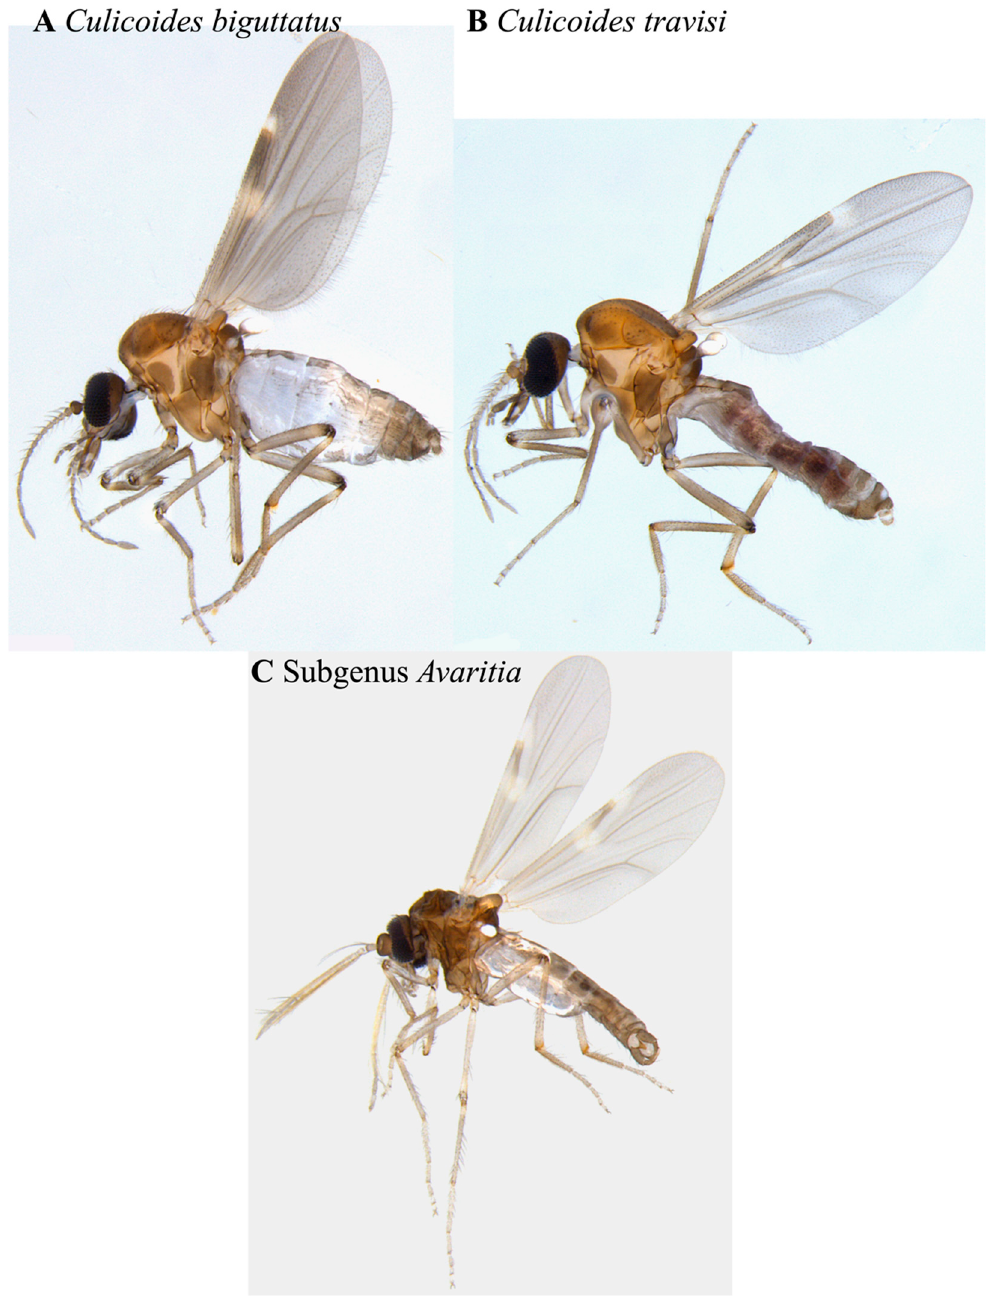
Figure 2. Representative images of Culicoides spp., morphologically identified from the Arboretum trap, showing a left lateral orientation. Specimens ( A , B ) are female, and specimen ( C ) is male. After a brief vortex, the tubes were stored at − 20 ◦ C overnight to facilitate DNA precipitation. DNA was then pelleted through centrifugation at 13,000 × g for 15 min. After careful disposal of the supernatant, the pellet was washed with 200 µ L of 70% ethanol. The ethanol was decanted and replaced anew after centrifugation at 13,000 × g for 15 min. The washing step was repeated, followed by brief vortexing and centrifugation at 13,000 ×